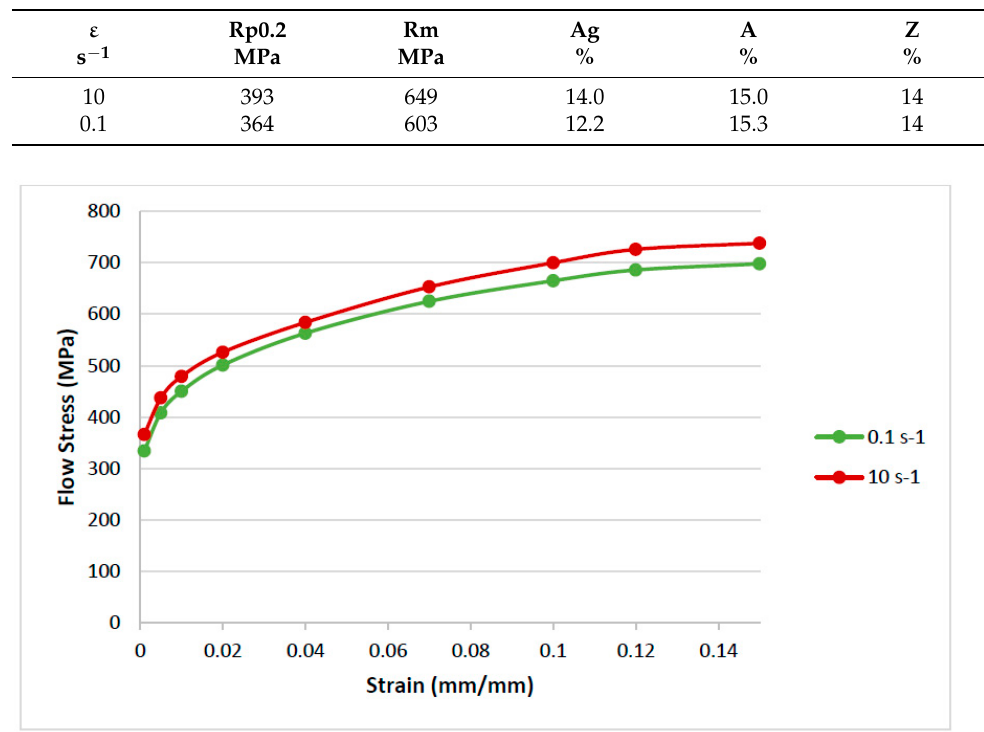
Figure 4. Flow stress data of borated austenitic stainless steel sheet in solution annealed state for two different strain rates, 0.1 s − 1 , and 10 s − 1 .